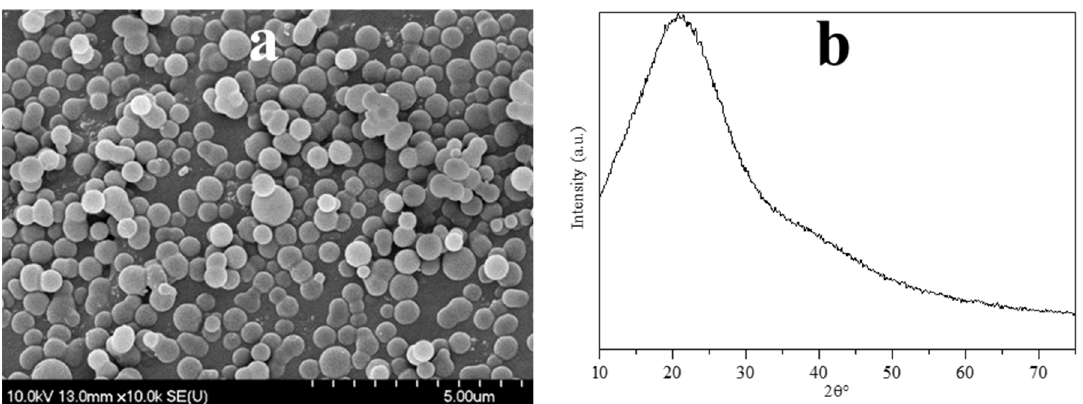
Figure 2. Typical SEM micrograph ( a ) and XRD diffractogram ( b ) of the obtained carbon spheres.